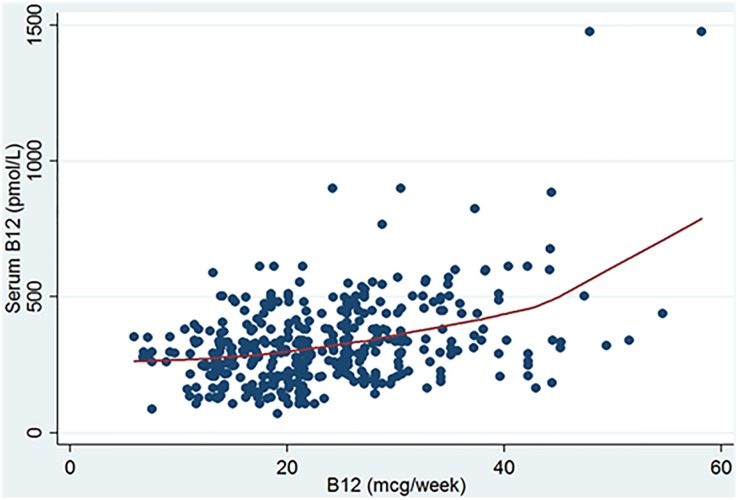
Non-parametric LOWESS curve with a scatter plot for the relationship between the average weekly vitamin B12 consumption and serum vitamin B12 (N = 412).